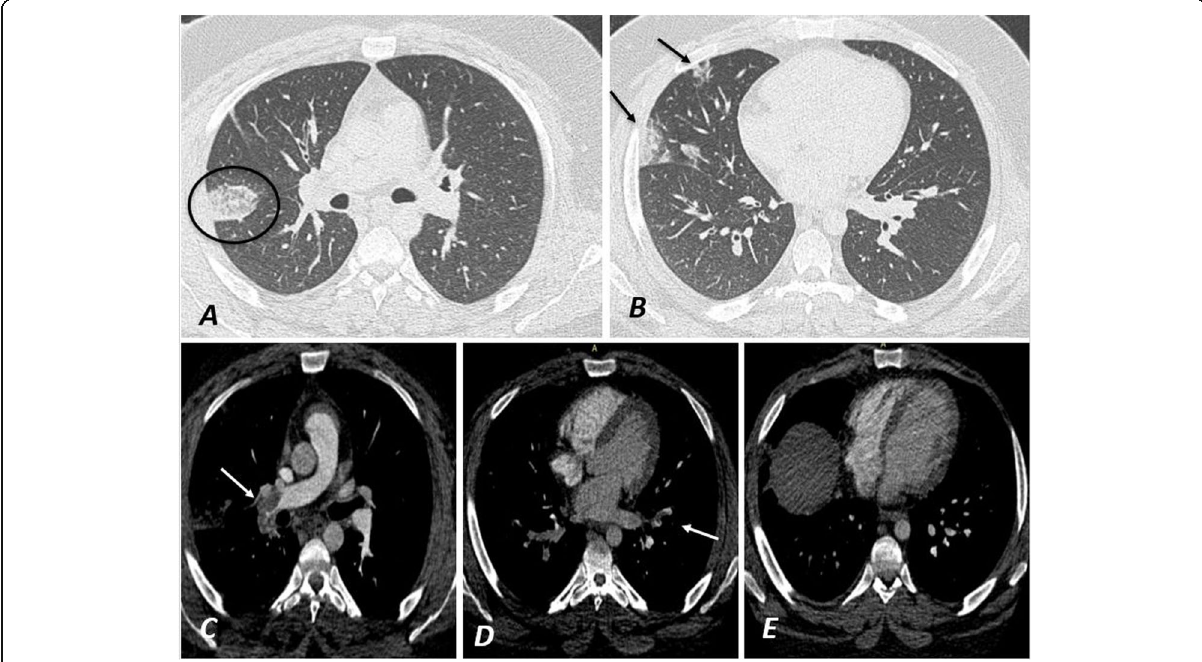
Fig. 2 A male patient 52 years old known case of COVID-19 infection as confirmed by PCR. He complained of chest pain 10 days after the onset of the disease. His D-dimer level was 1.6 μ g/ml. a , b Axial CT images of the patient, showing right side peripheral pulmonary reversed halo sign (the black circle in image a ) with scattered right peripheral pulmonary ground-glass opacities (black arrow in b ). A pulmonary embolism was suspected for which CTPA was done and revealed pulmonary embolism involving the right inter-lobar artery (white arrow in c ), partial embolism of the segmental branches of the left lower lobar artery (white arrow in d ) with no CT evidence of right ventricular strain with normal RV/LV ratio and normal rightward deviated IV septum as seen in image